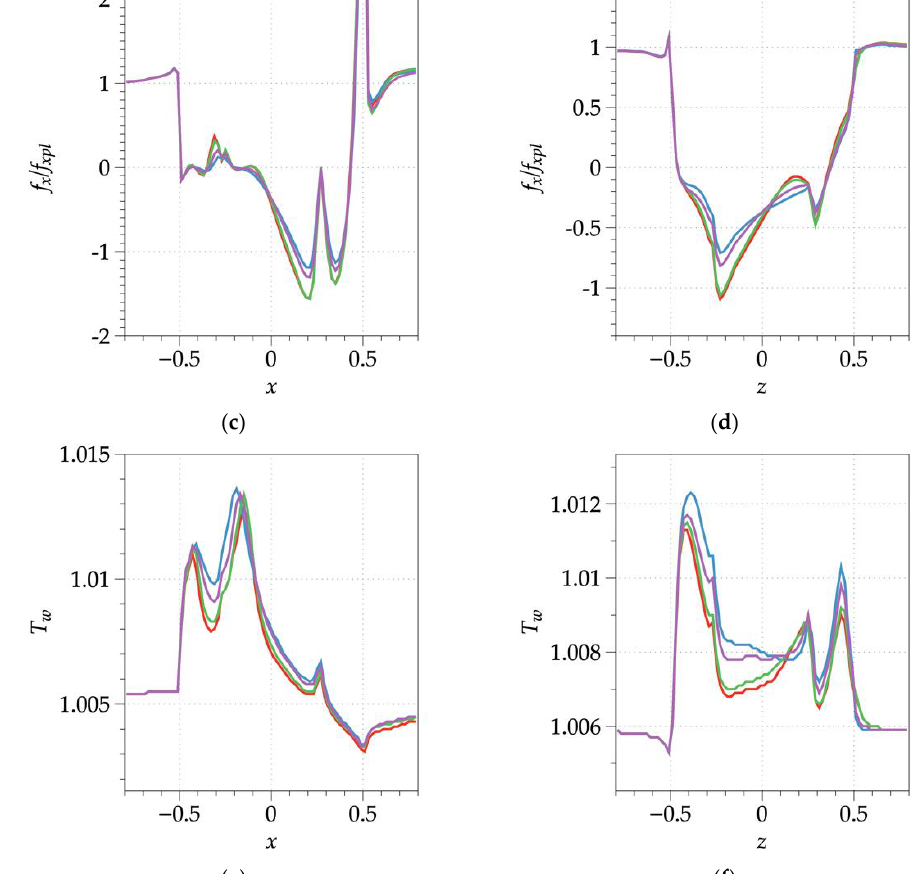
Figure 6. Distributions of the static pressure drop 𝑝 − 𝑝 𝑝𝑙 ( a , b ), the relative friction 𝑓𝑥/𝑓𝑥 𝑝𝑙 ( c , d ), and the temperature 𝑇 𝑤 ( e , f ) in the middle longitudinal ( a , c , e ) and transverse ( b , d , f ) sections of the dimpled wall of the channel for the different standard SST models and the modified Menter SST models. Red line—Menter 1993 SST model, Blue line—Menter 2003 SST model, Green line—Menter SST model corrected according to RLI, and Purple line—Menter SST model corrected according to SM.